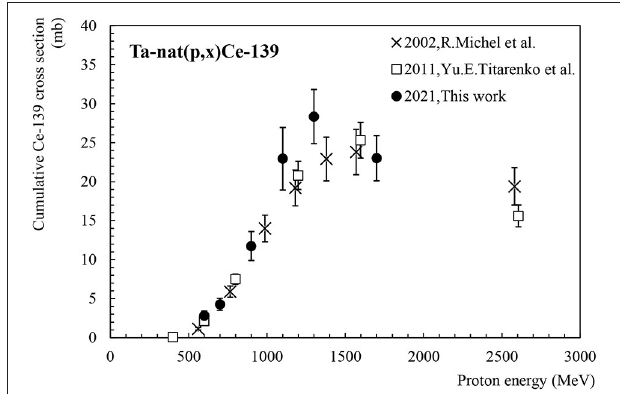
FIGURE 3 | Cumulative cross-section for Tb-149 production as a function of the proton beam